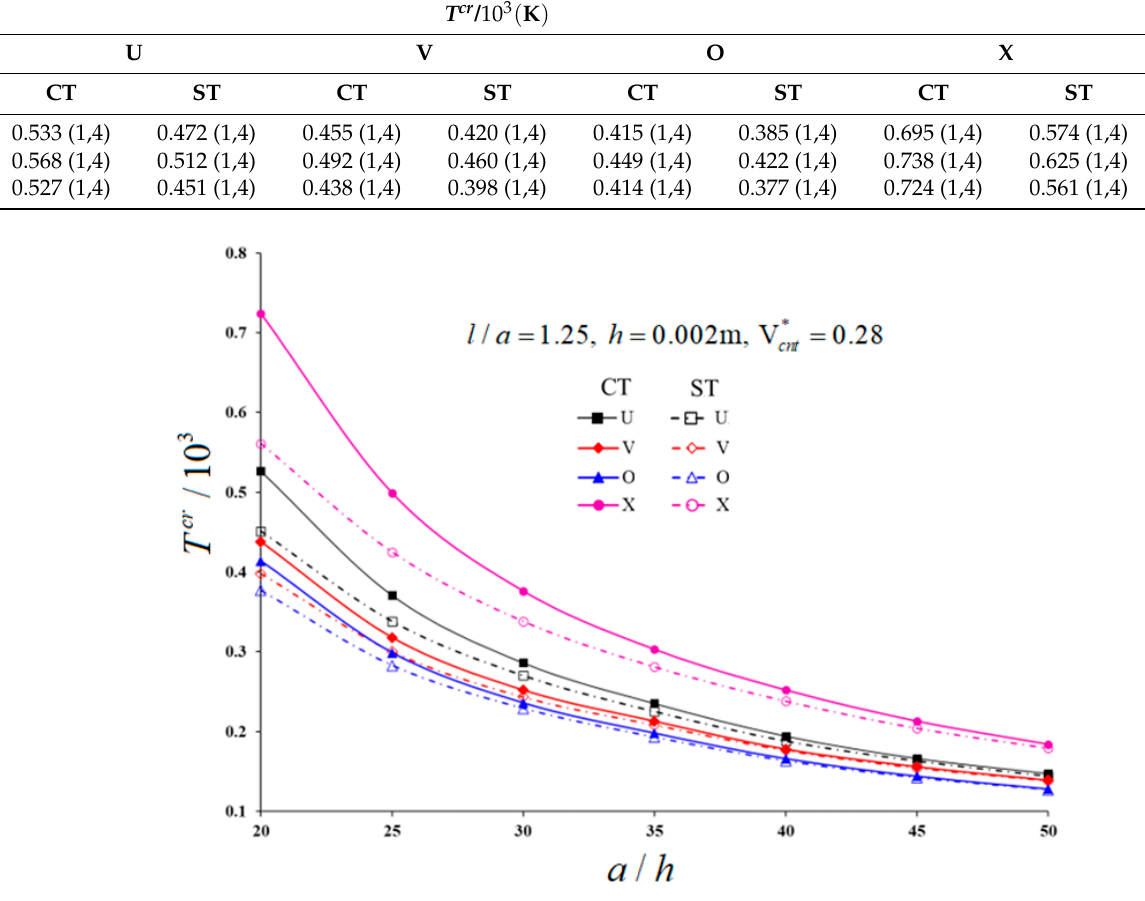
Figure 3. Variation of CUT for nanocomposite cylindrical shells against the a / h ratio within ST and CT.